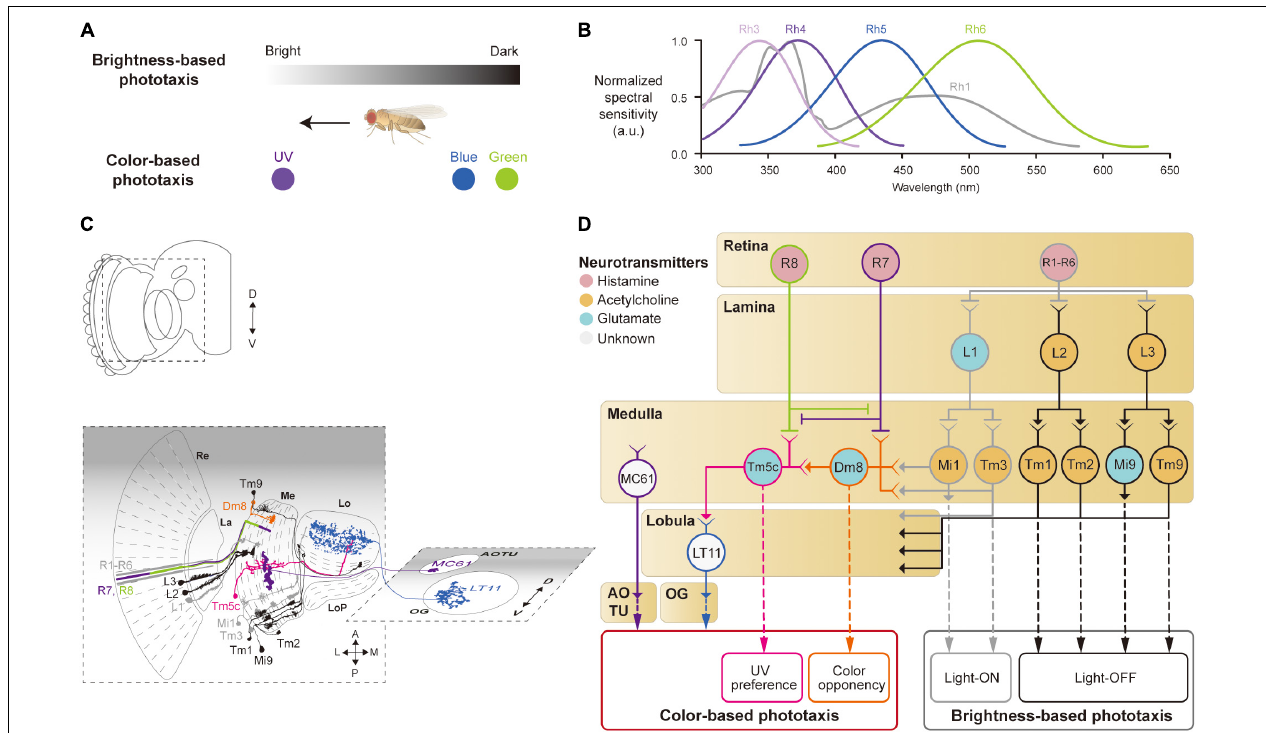
FIGURE 2 | Neural circuits underlying the detection of brightness and colors for the phototaxis behavior. (A) Drosophila shows phototactic behaviors, seeking bright against dark (top) or ultraviolet (UV) against blue/green (bottom). (B) Spectral sensitivity curves of rhodopsins expressed in photoreceptor cells Graphical depiction is adapted from Hu and Stark (1977), Fischbach (1979), Gao et al. (2008), Yamaguchi et al. (2010), and Karuppudurai et al. (2014). (C) Schematic illustration of the structures and neurons described in panel (D) . Images of neurons are adapted from Fischbach and Dittrich (1989) and Otsuna et al. (2014). Re: retina, La: lamina, Me: medulla, LoP: lobula plate, Lo: lobula, OG: optic glomeruli, AOTU: anterior optic tubercle. (D) Schematic of a neural circuit related to the phototaxis. Photoreceptor cells (R1 – R6) detect changes in brightness and pass light-ON (gray outlines) or OFF (black outlines) information to downstream neurons. R7 and R8 cells respond to UV light (purple and green outlines) and convey the information to different neural pathways for color-based phototaxis (orange, pink and blue outlines), which include color opponency (orange outline) and UV preference (pink outline). The face color of a circle represents the type of neurotransmitters released by a neuron, and the line color of a circle matches that of the neuron in panel (C) .